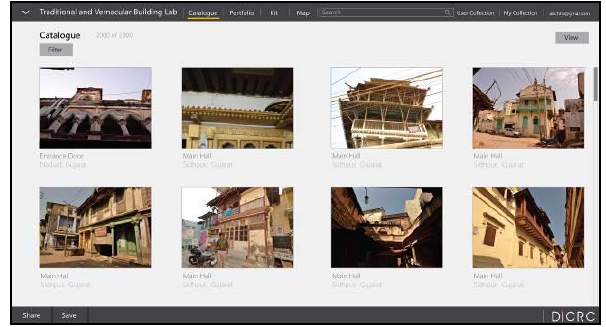
Figure 15. TVB Lab - Interactive